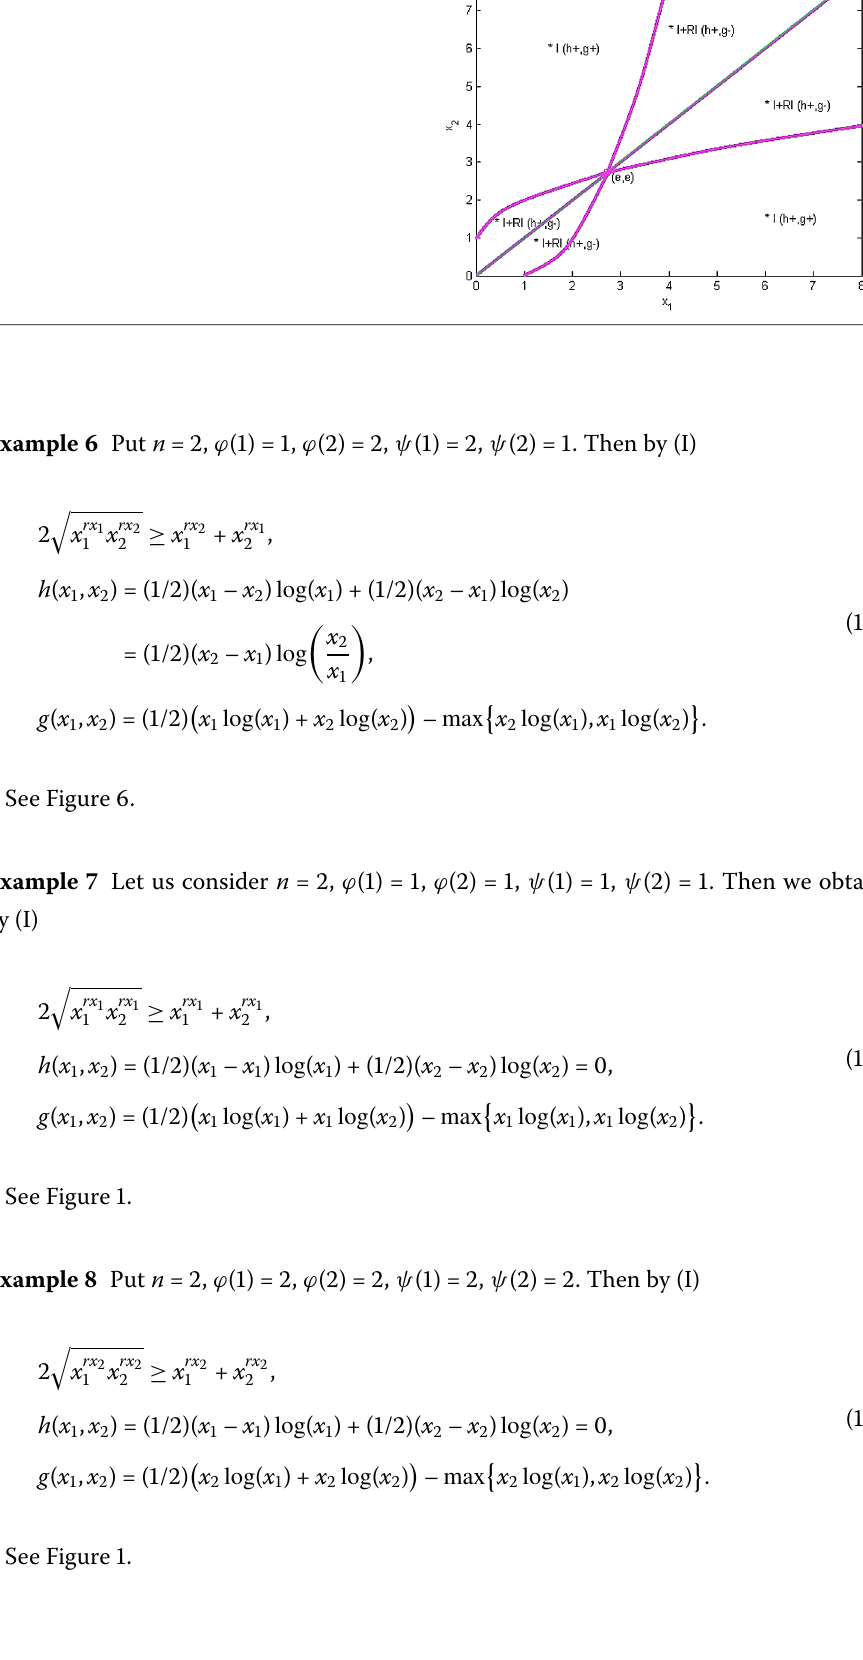
Figure 6 Solution points for inequalities Example